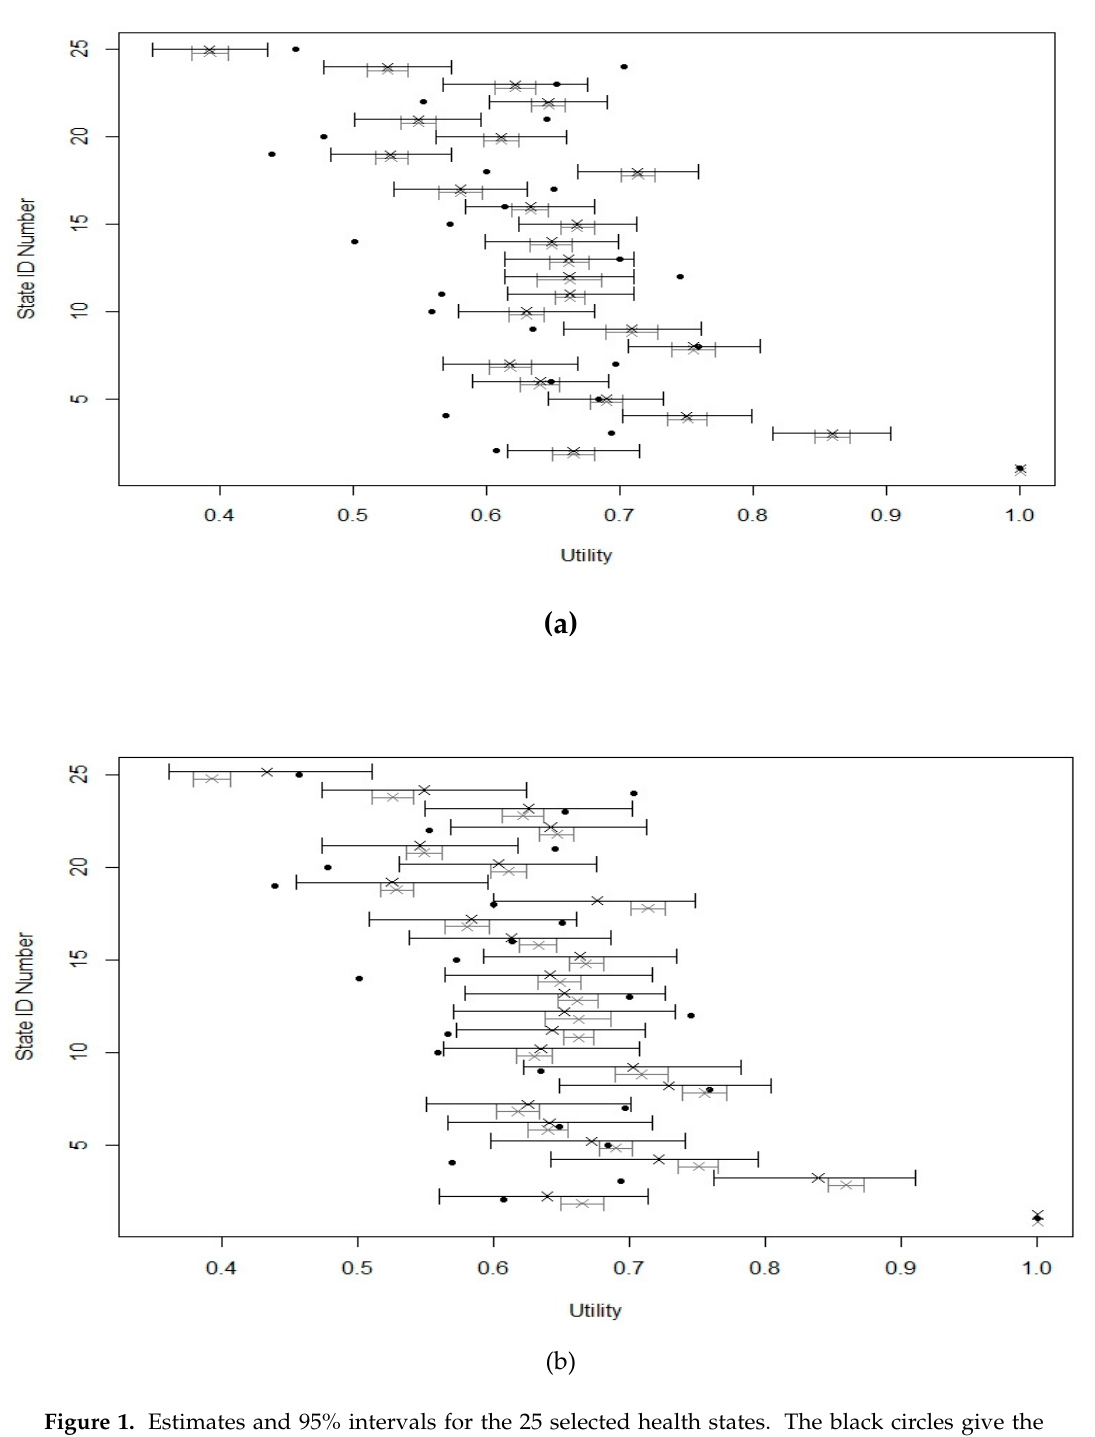
Figure 1. Estimates and 95% intervals for the 25 selected health states. The black circles give the observed mean utilities for each valued health state. The gray crosses and lines indicate the predicted means and 95% confidence intervals, ignoring parameter uncertainty. The black lines are the 95% confidence intervals from (a) the probabilistic sensitivity analysis (PSA) approach and (b) the Bayesian approach, respectively, that acknowledge uncertainty.